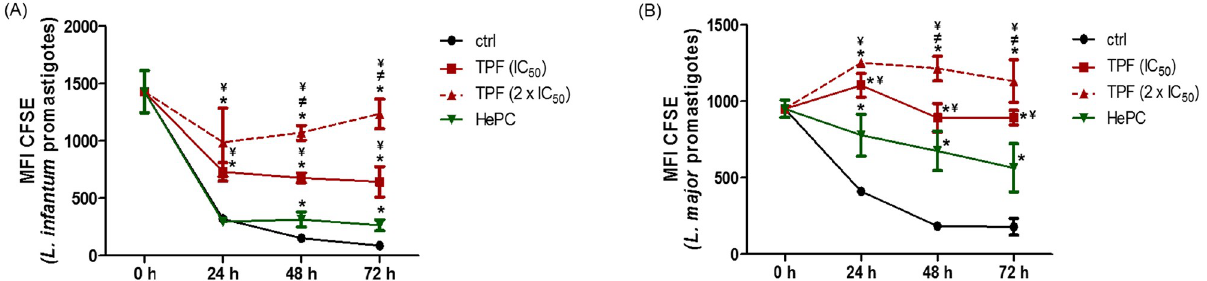
Fig 3. Leishmania spp. promastigote proliferation determined by CFSE staining. L . infantum (A) and L . major (B) early exponential-phase promastigotes were treated with IC 50 and 2 x IC 50 concentrations of TPF and their proliferation rate was qualitatively monitored at 24 h intervals for 3 consecutive days by CFSE staining and subsequent analysis of fluorescence intensity in FACS. HePC (IC 50 )-treated and untreated parasites were used as positive and negative control groups, respectively. The results are expressed as mean fluorescence intensity values ± SD of three independent experiments. Symbols of � and ¥ indicate statistically significant differences compared to negative and positive control groups, respectively, while 6¼ indicates significant differences between TPF groups.